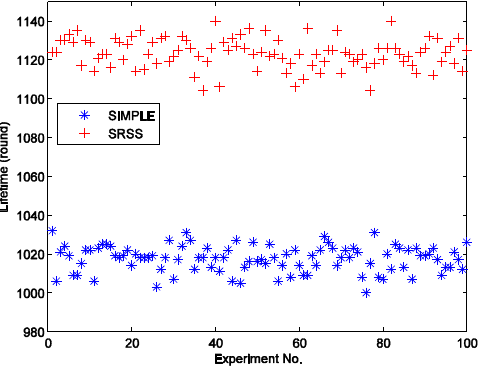
Figure 5. The lifetime of wireless sensor networks with different